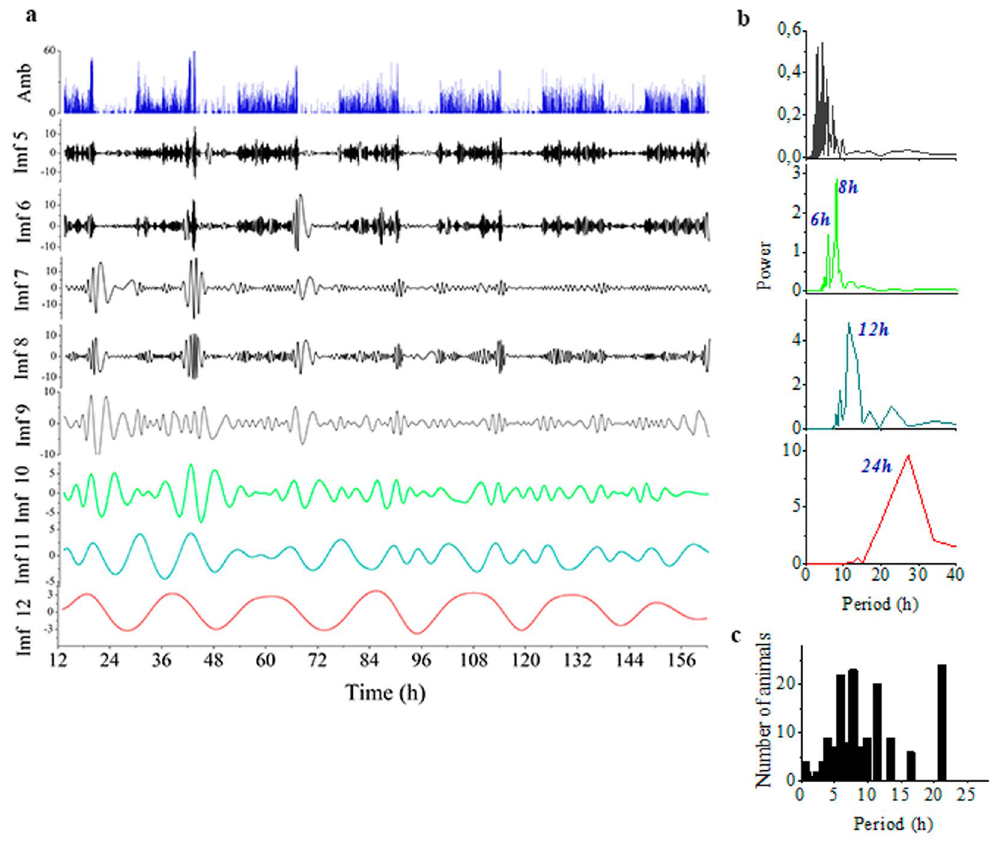
Figure 3. Empirical Mode Decomposition (EMD) of time series in ambulatory activity. ( a ) EMD of the actogram constructed using a 30 s time window (top panel in blue). For visualization, of the 15 Intrinsic Mode Functions (IMFs) found only 9 are shown (IMFs 5–12). Note the smooth oscillations observed in all IMFs. The Power Spectrum Analysis (PSA) of IMFs 9–12 are depicted in ( b ). For EMD a 30 sec window was selected as a tradeoff between the need for a large number of data points for PSA, and the advantage of smoothing the time series by pooling data in larger time windows. ( c ) A histogram of the principle peaks in PSA of IMFs detected in all animals is shown. Note that circadian and ultradian rhythms were observed in all animals, namely with periods of 24 h, 12 h, 8 h, 6 h and 4 h. Principal peaks was defined as the largest 10 peaks that appear at least once in the PSA of a subgroup of 4 IMFs (equivalent to the 4 selected in “c”), where the height of the peak was larger than 30% of the power of the highest peak of the corresponding